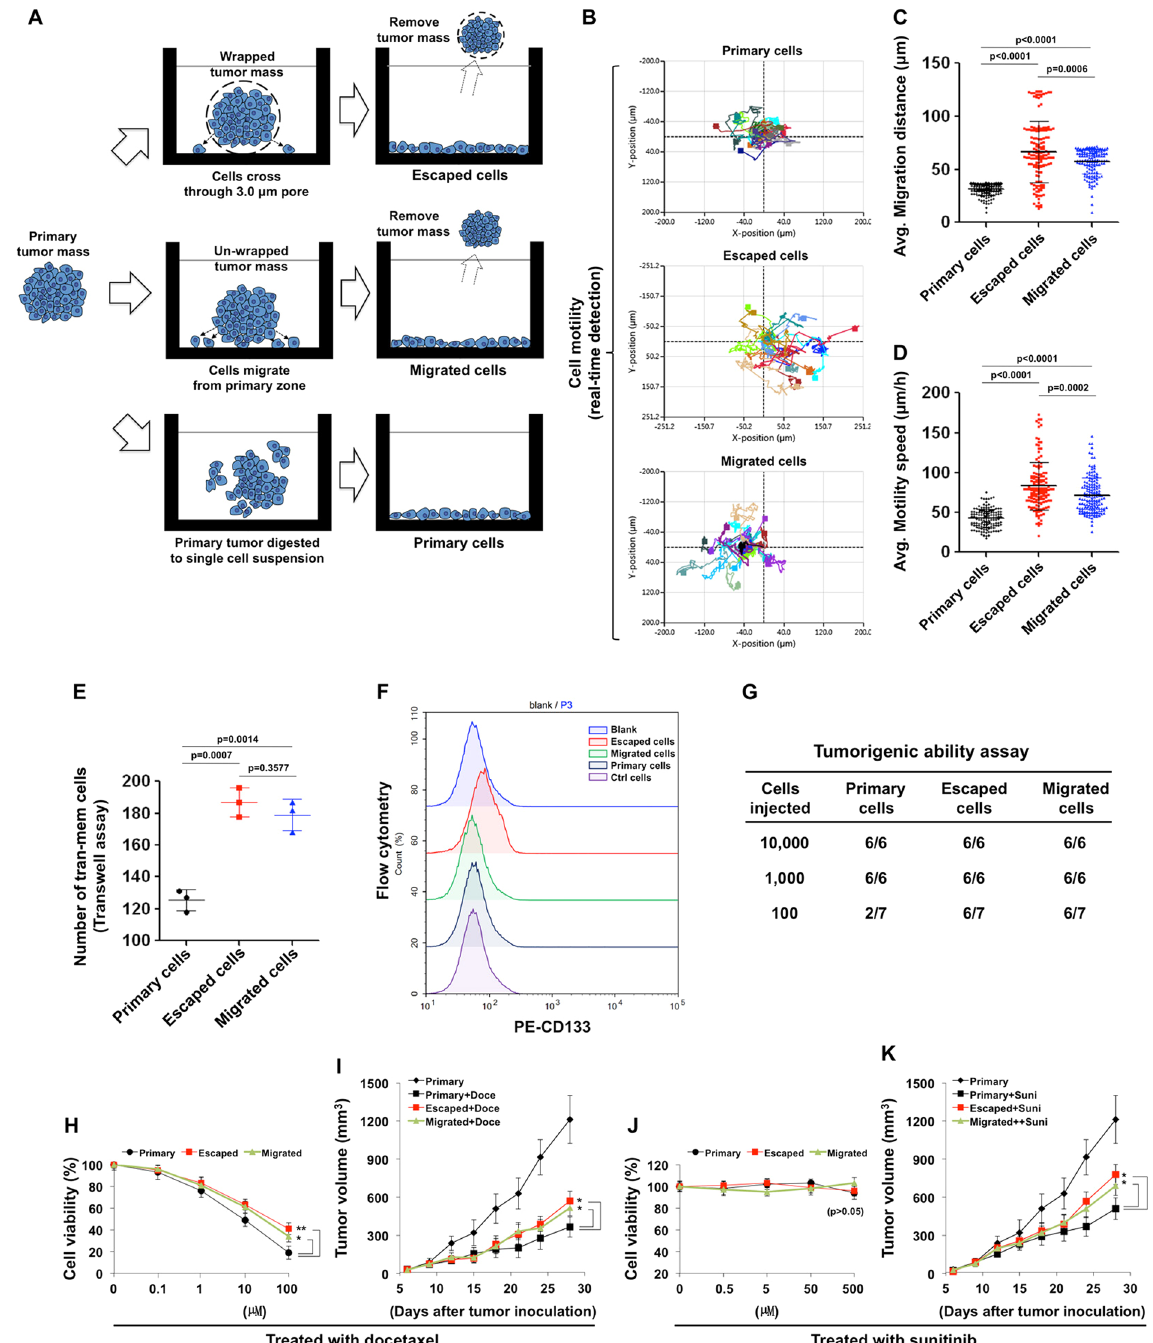
Figure 8. The tumor malignancy was further increased during the tumor escaping process. ( A ) The encapsulated 4T1 tumor was incubated in the 6-well plate. After the tumor cells escaped through the micro-pores, the tumor mass was entirely removed, and the cell remaining on the bottom of the plate were named as “Escaped cells”. The cells migrated from the un-wrapped tumors were named as “Migrated cells”. The primary orthotopic tumor was directly minced and digested to single cell suspension, and named as “Primary cells”. ( B–D ) The cells were then subjected to the real-time detection of cell motility. 19 cells of each group were randomly chosen for the analysis. ( B ) The motion trail of each chosen cell. ( C ) The average migration distance ( μ m) and ( D ) the average motility speed ( μ m/h) of the 19 cells at each time point was calculated using the software HoloMonitor ver.2.6.1. The cells were also subjected to transwell assay to evaluate the invasion ability ( E ) and flow cytometry to detect CD133 ( F ). ( G ) The tumorigenic ability of the cells was determined by limiting dilution assay. ( H,J ) The cell viability was measured after the treatment of docetaxel or sunitinib. ( I,K ) 2 × 10 6 Primary, Escaped, or Migrated cells were injected into the mammary fat pad. After 6 days of inoculation, mice were treated with docetaxel (5 mg/kg) or sunitinib (40 mg/kg), and the tumor volume was measured every 3 day (n = 6). Statistical differences between groups were examined using the 2-tailed Student’s t- test, and a p value < 0.05 was considered statistically significant ( * p < 0.05; ** p <